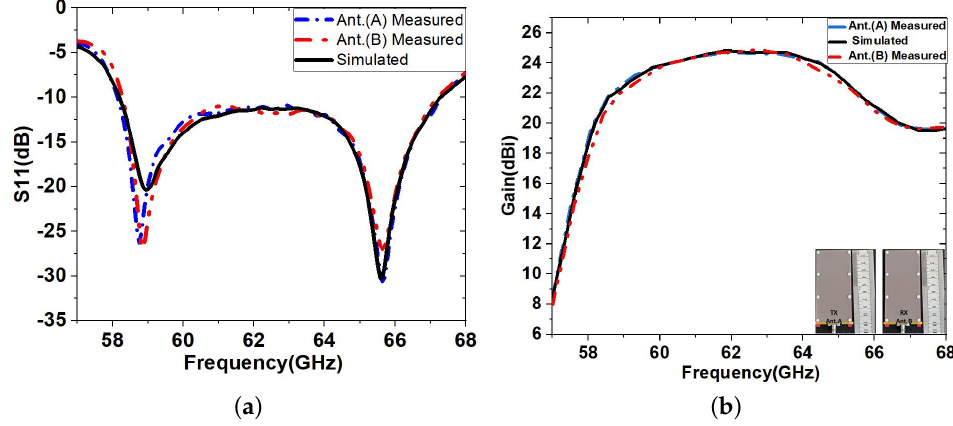
Figure 10. Measured LWA results compared to simulated in ( a ) S 11 and ( b ) Realised gain.